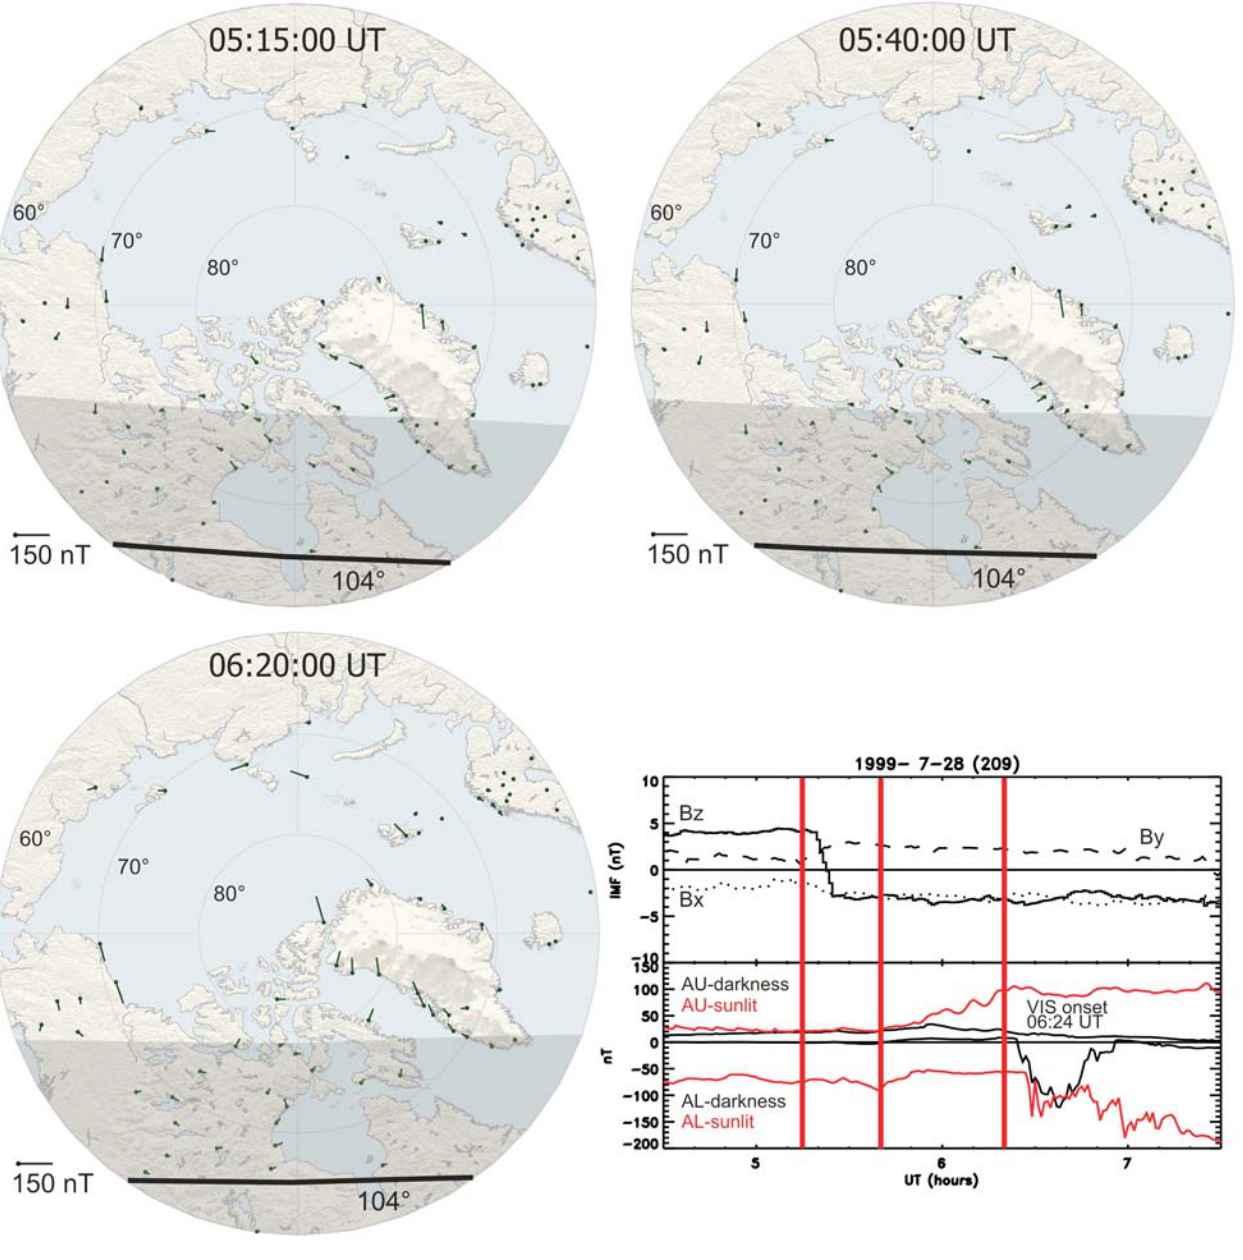
Figure 2 Fig. 2. A typical event from 28 July 1999 when most of the auroral region was sunlit. Same format as Fig.